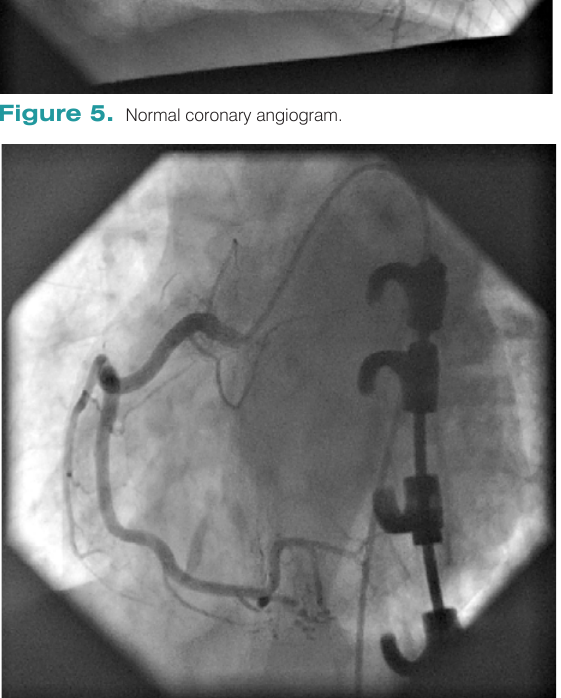
Figure 6. Normal coronary